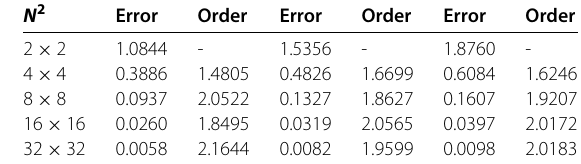
Table 1 The error and order at t = 0.4 s ,0.7 s ,1.0 s , respectively.